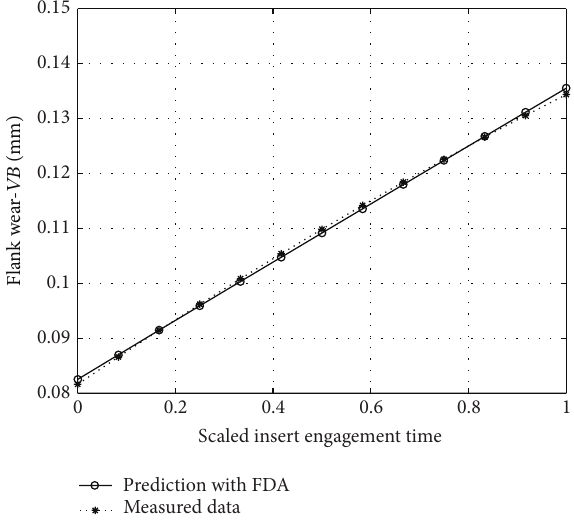
Figure 7: Comparison of the flank wear values predicted with the proposed model and experimentally measured ones for one randomly chosen functional datum out of the testing data